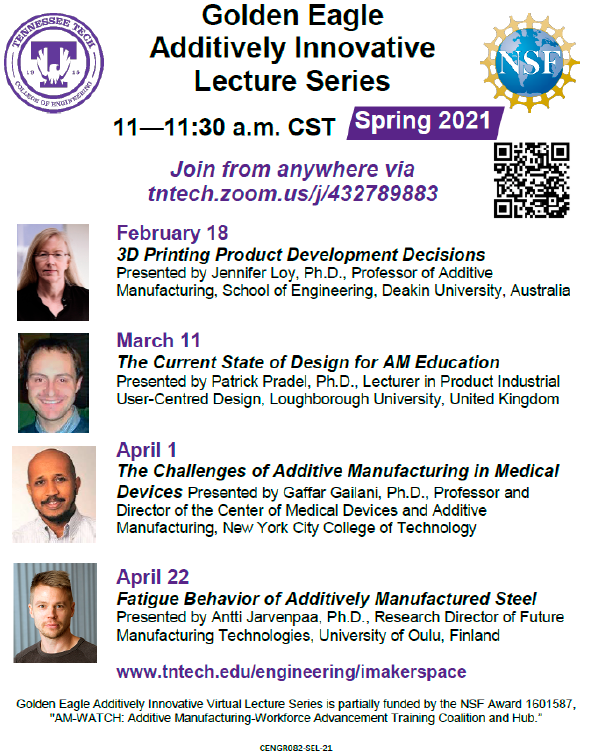
Figure 4. Flyer for the Spring 2021 Golden Eagle Additively Innovative Virtual Lecture Series .